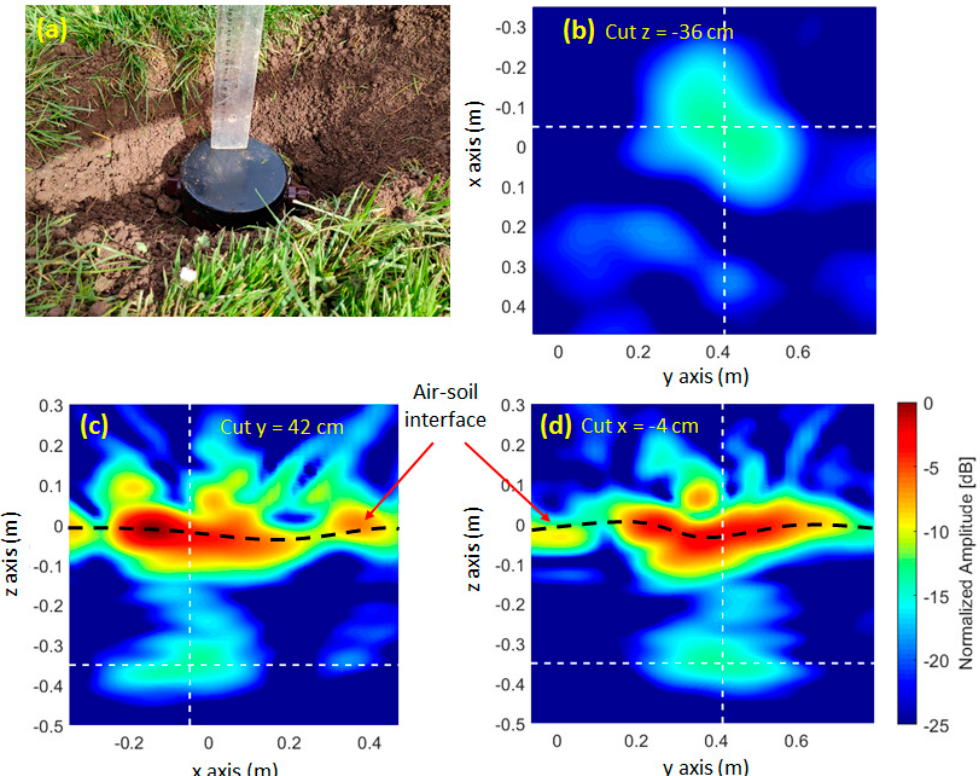
Figure 11. Picture of the anti-personnel plastic landmine ( a ). Reflectivity normalized amplitude, in dB: cut z = − 36 cm ( b ), cut y = 42 cm ( c ), cut x = − 4 cm ( d ).